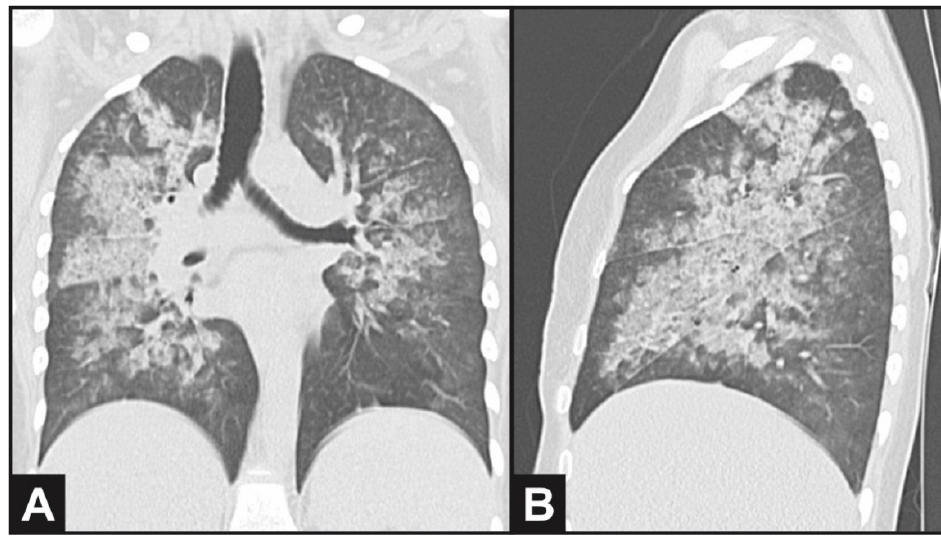
Figure 1. Computed thorax tomography evidencing bilateral and diffuse ground-glass opacities in ( A ) coronal and ( B ) sagittal plane view, compatible with alveolar hemorrhage .